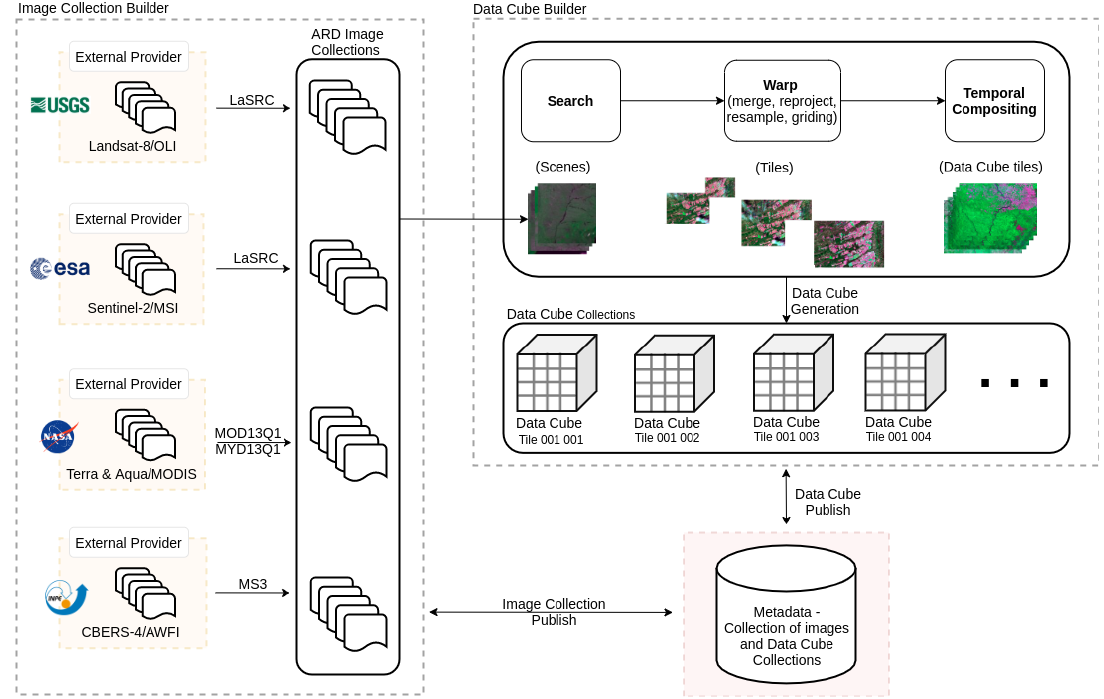
Figure 2. Data acquisition, ARD processing, and data cube generation.